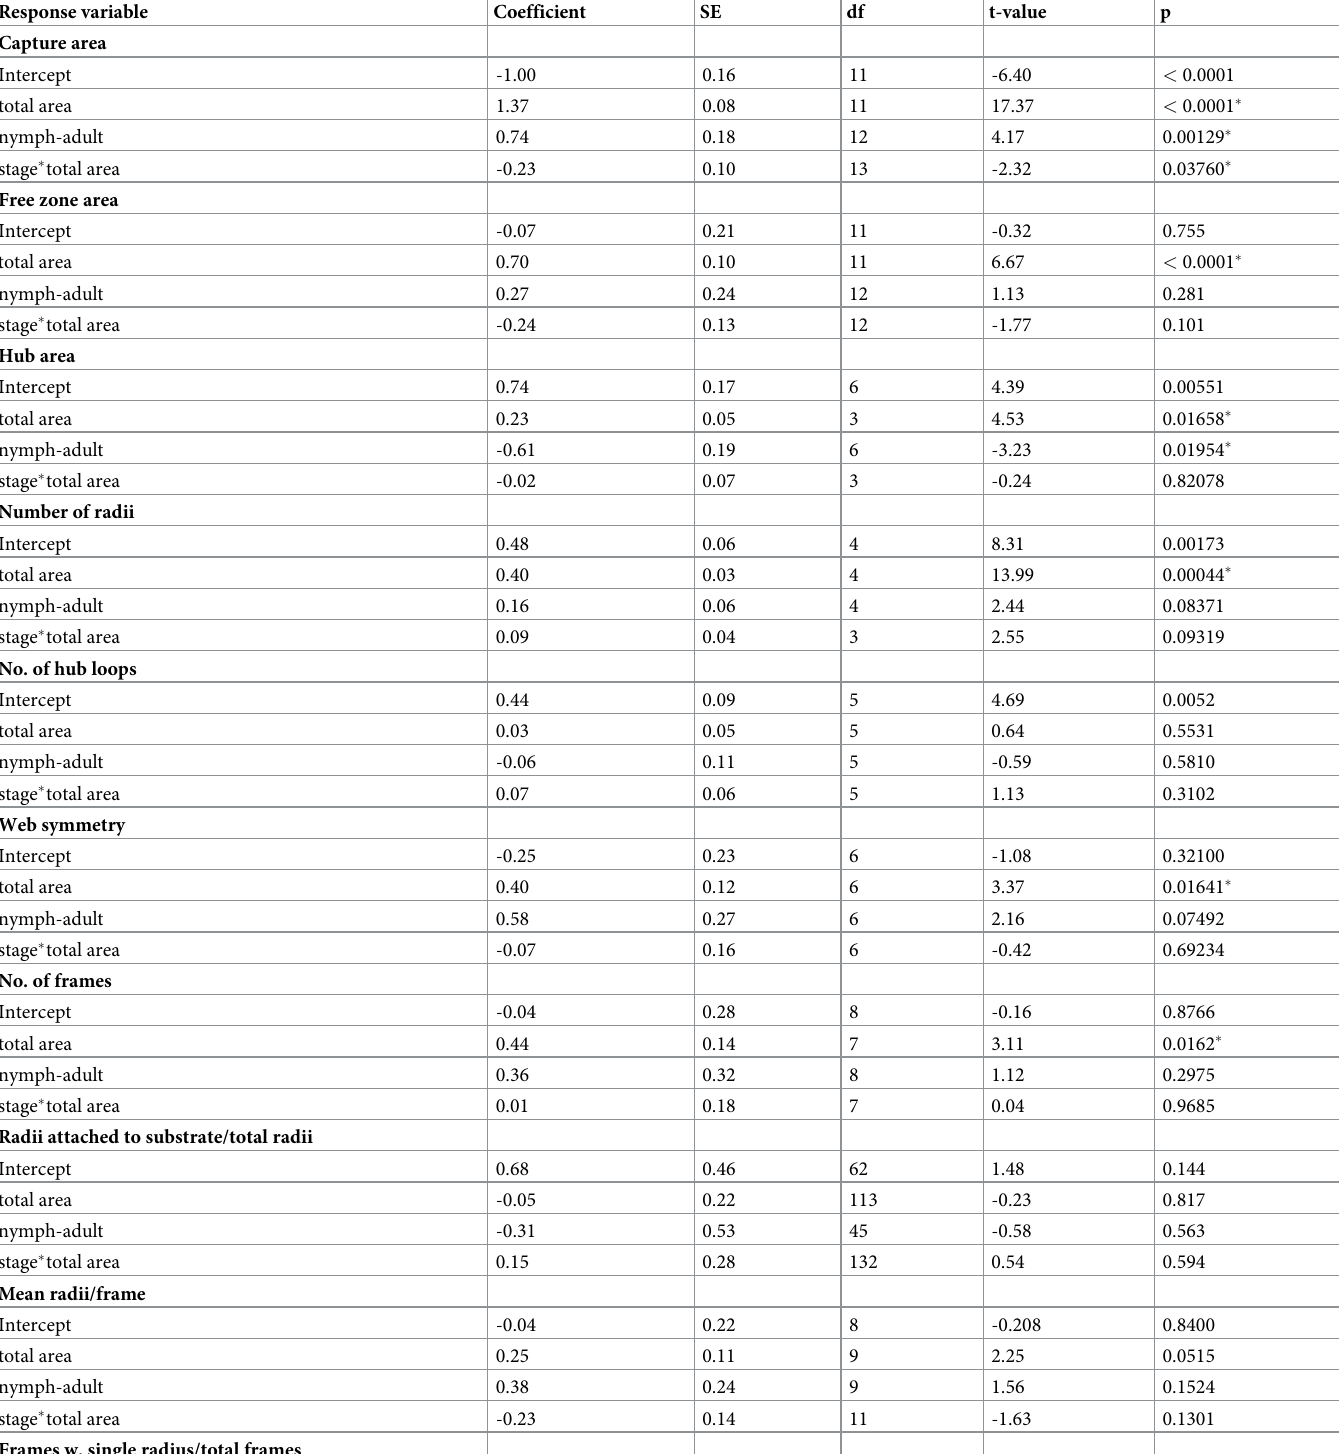
Table 1. Effect of total area of the web, spider stage (nymphs vs adults), and interaction (stage � total area) on log transformed web variables (as defined in Methods), using general linear mixed models, with spider size category and size of the container where Leucauge argyra spiderlings and adults constructed their webs as ran- dom